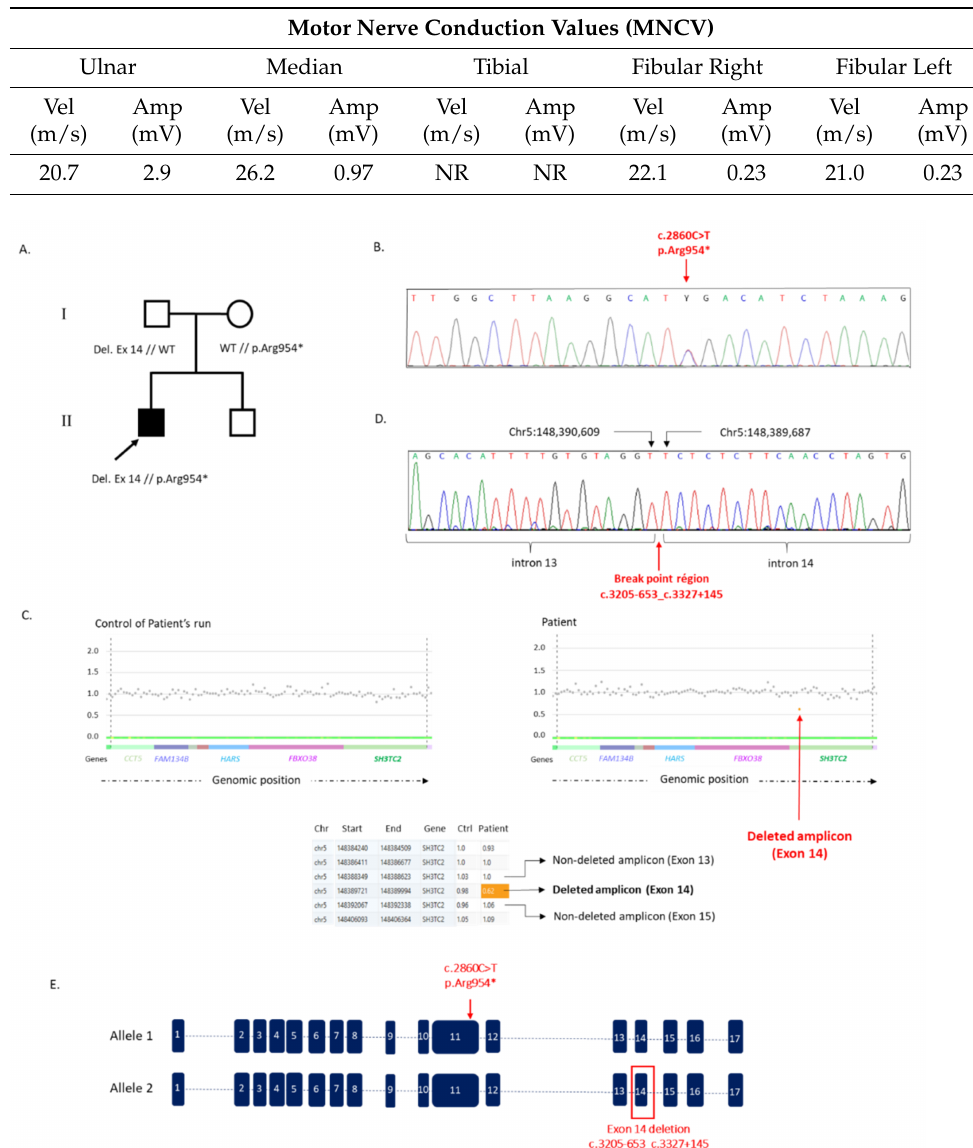
Table 1. Patient’s neurophysiological recordings. Abnormal values are represented in bold. Normal values of MNCV: ulnar (>52 m/s; >7.9 mV), median (>49 m/s; >4.1 mV), tibial ((>39 m/s; >4.4 mV), fibular (>43 m/s; >1.3 mV) [25]. (Vel: velocity; Amp: amplitude; NR: no response).